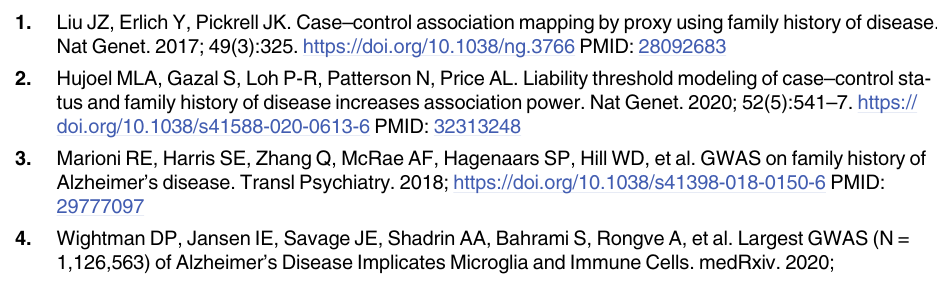
S7 Table. Lead SNPs and tagged SNPs for GSEM AD previously identified in GWAS of dis- eases and traits listed in the GWAS catalog. S8 Table. Independent lead SNPs and SNPs tagged within each significant genomic locus for GSEM AD. S9 Table. Type I error rates for heritability estimates simulated from a null model (100 iterations). S10 Table. Supplemental experimental conditions for the simulation of summary statistics and SNP effect sizes for continuous traits. S11 Table. Recovery of SNP-based heritability across supplemental experimental condi- tions and methods for continuous traits (100 runs per condition). S12 Table. Recovery of individual SNP effects across supplemental experimental condi- tions and methods for continuous traits (100 runs per